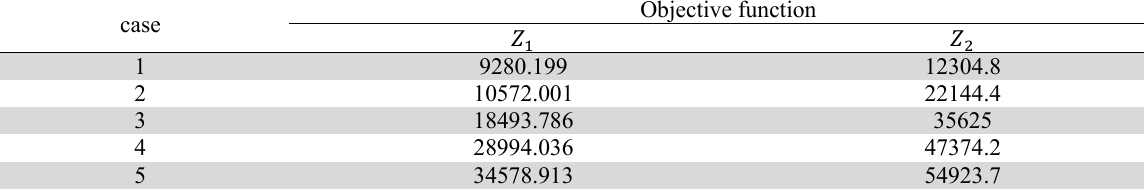
Computational results of numerical example